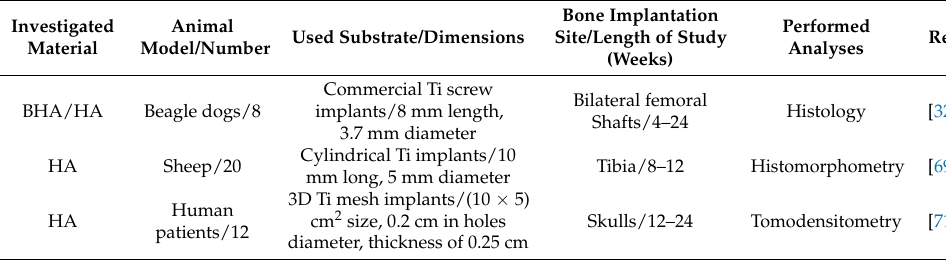
Table 6. Information related to the investigated coating materials, according to the applied large animal models (i.e., dogs/sheep/human